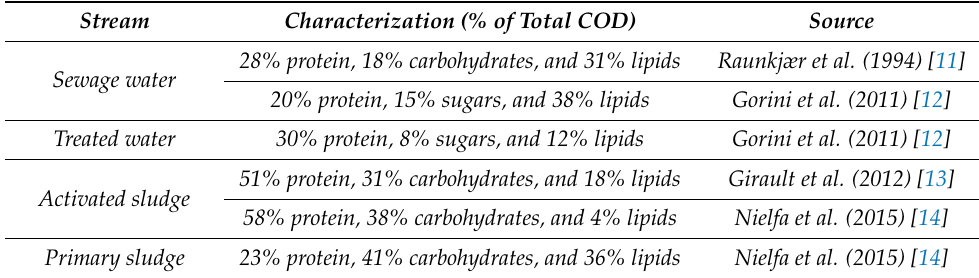
Table 1. Characterization of SWTP streams in terms of composition of COD